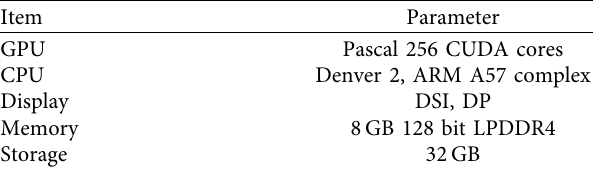
Table 1: Hardware and confguration